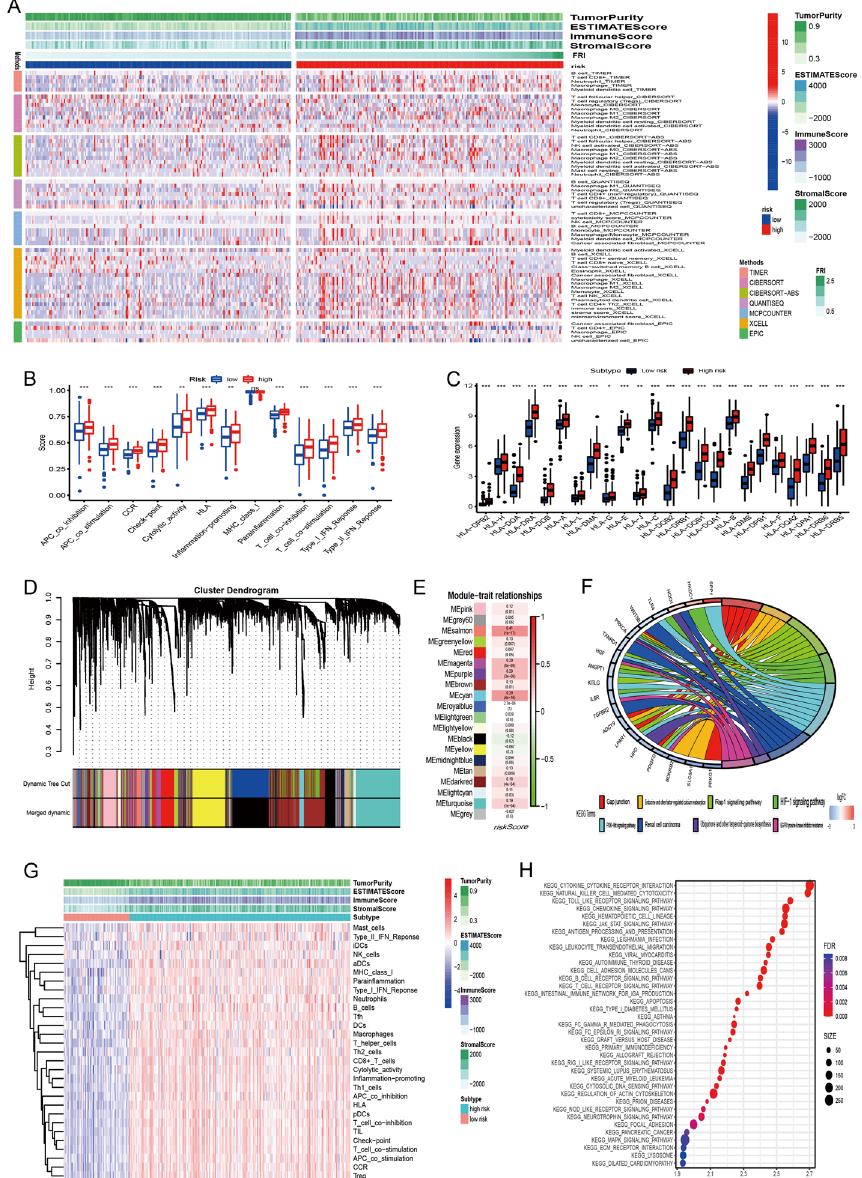
Fig. 7 Cellular and molecular characteristics of 5‑lncRNA risk subtypes. A The landscape of immune cell infiltration in TCGA cohort. B Difference in the immune related signaling pathways. C Gene expression of HLA gene sets between two distinct clusters. D Dendrogram of all differentially expressed genes clustered based on a dissimilarity measure (1‑TOM). E , F Weight gene co‑expression analysis and function enrichment analysis. G The landscape of immune cell infiltration in IMvigor210 cohort. H Functional annotation in IMvigor210